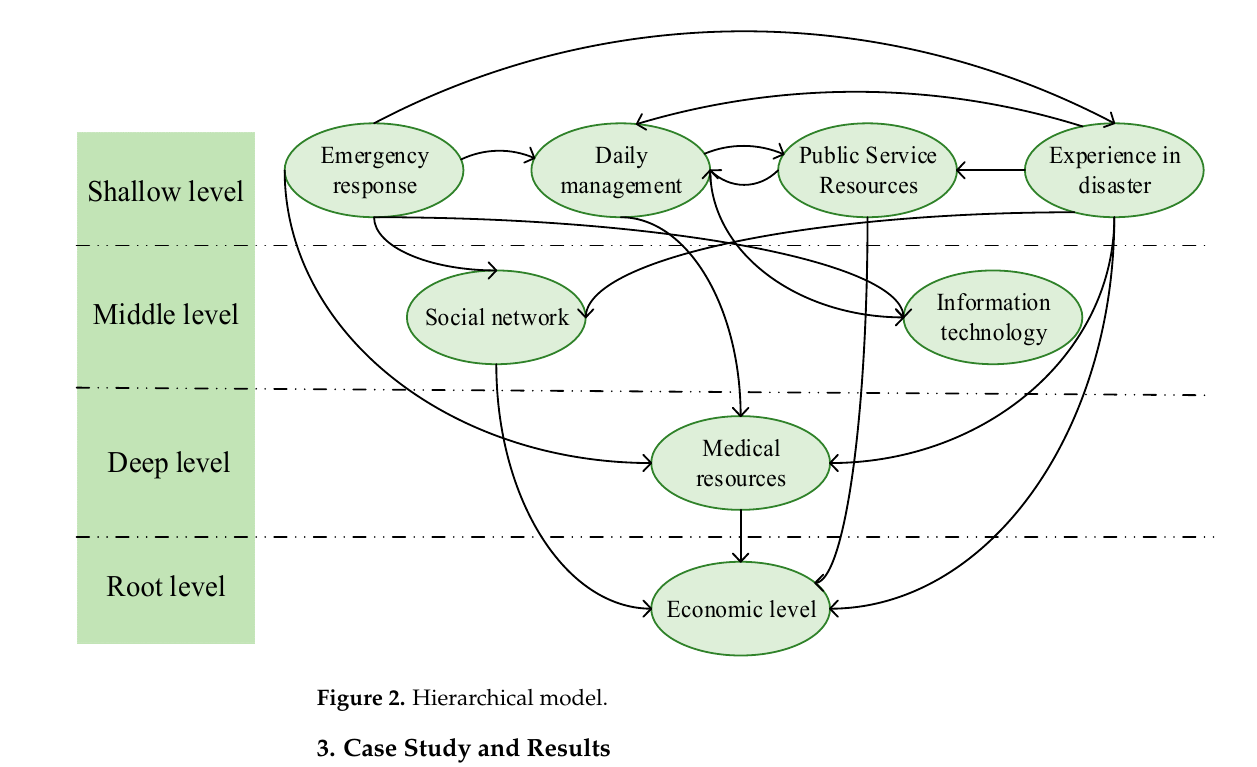
Figure 2. Hierarchical model.